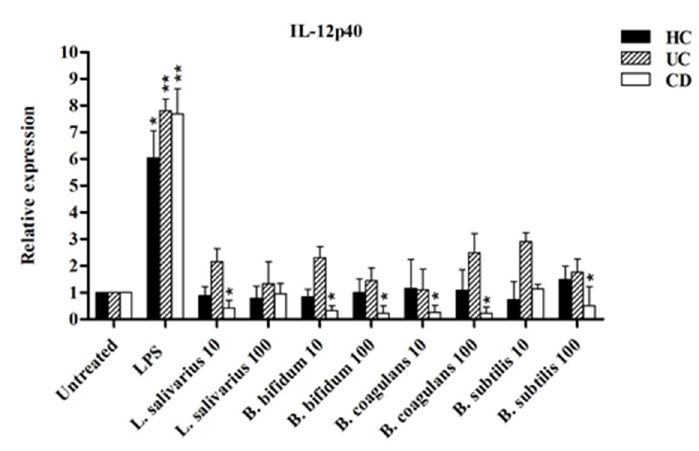
Figure 7. IL-12p40 expression after stimulation with probiotic bacteria. * p < 0.05, ** p < 0.01.